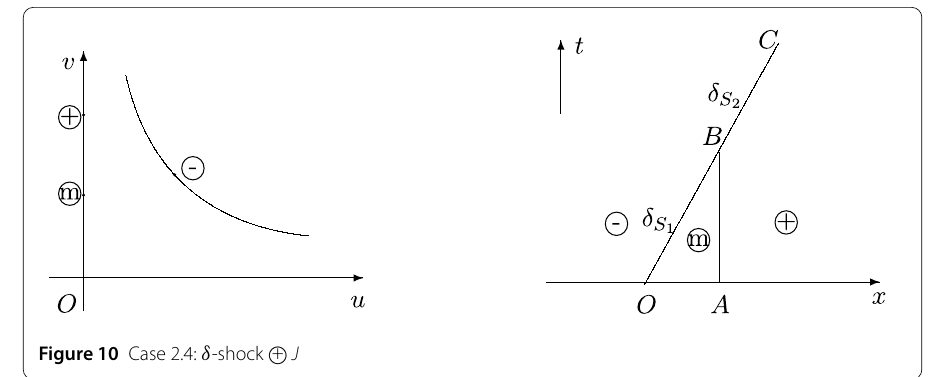
Figure 10 Case 2.4: δ -shock + (cid:10)